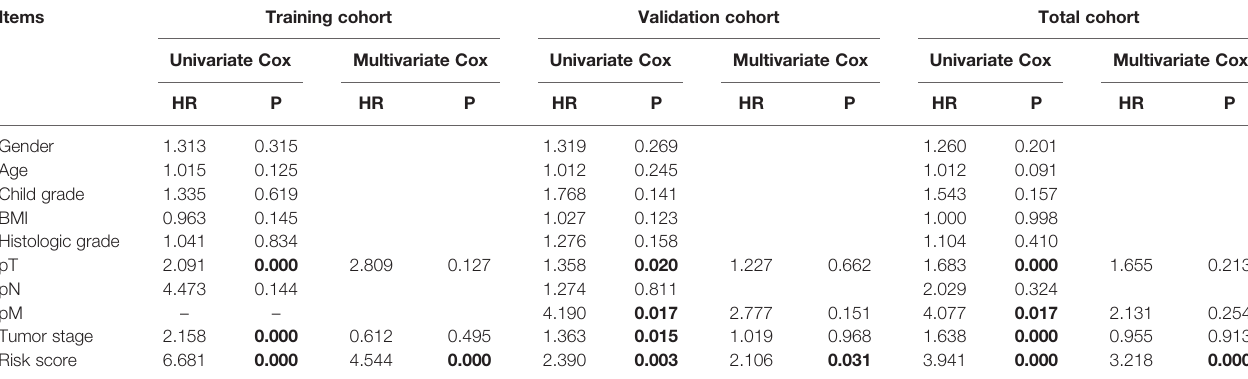
TABLE 3 | Univariate and multivariate Cox regression analyses of clinicopathologic factors for overall survival in HCC from the TCGA database. Items